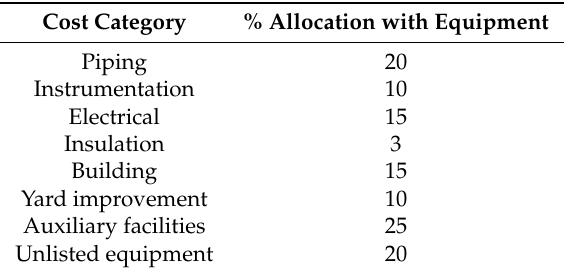
Table 3. Direct plant cost categories and their percentage allocation with equipment cost [67].